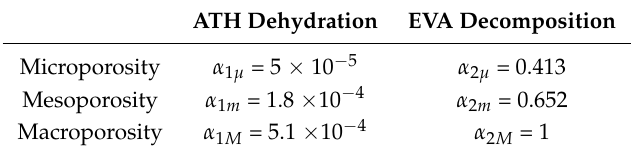
Figure 9. Evolution of the porosities on various scales as functions of the advancement parameters α 1 and α 2 . φ n is given with respect to the volume of mineral grains. Φ µ , Φ m and Φ M are given with respect to the total sample volume. The threshold values of α 1 and α 2 are given in Table 2 . Table 2. Thresholds of the advancements α 1 and α 2 for porosity